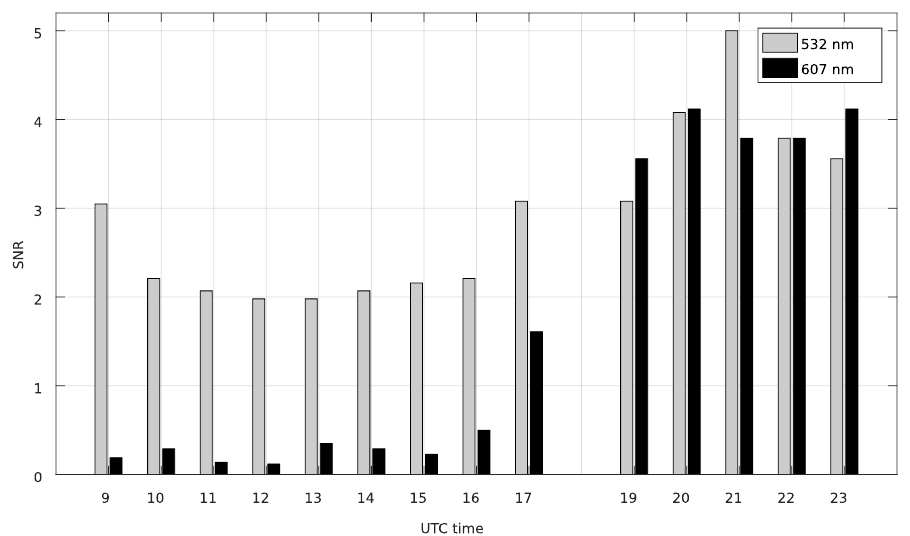
Figure 5. Changes in signal-to-noise ratio (SNR) for channels 532 nm and 607 nm of near-range aerosol Raman lidar (NARLa) at 1 km height on 03/08/2015 at SolarAOT